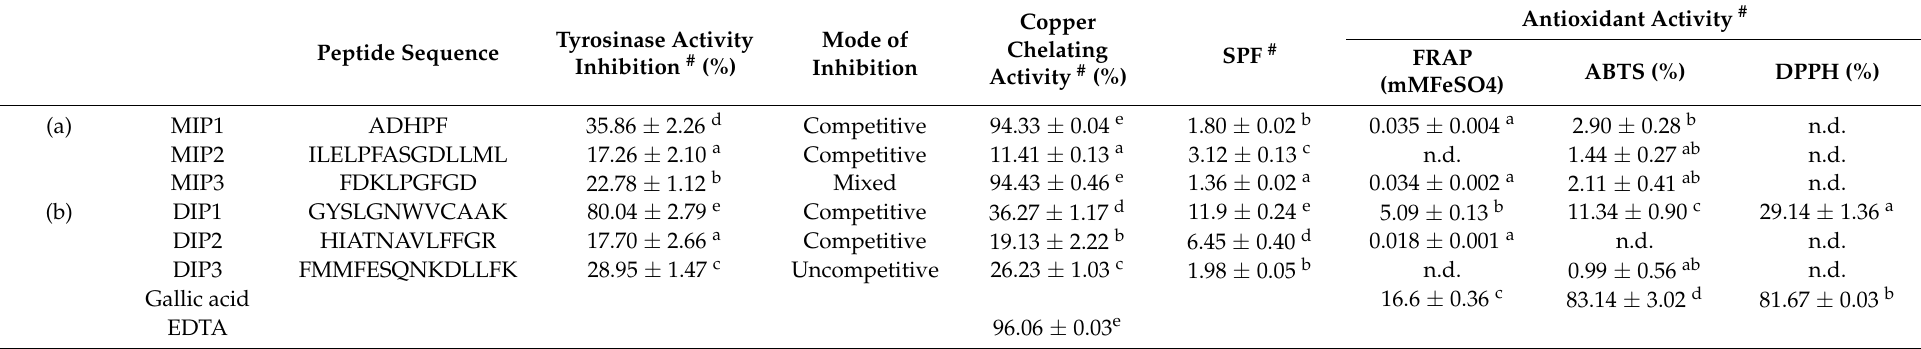
Table 1. Summary of the biological activities of (a) monophenolase inhibitory peptides (MIPs) and (b) diphenolase inhibitory peptides